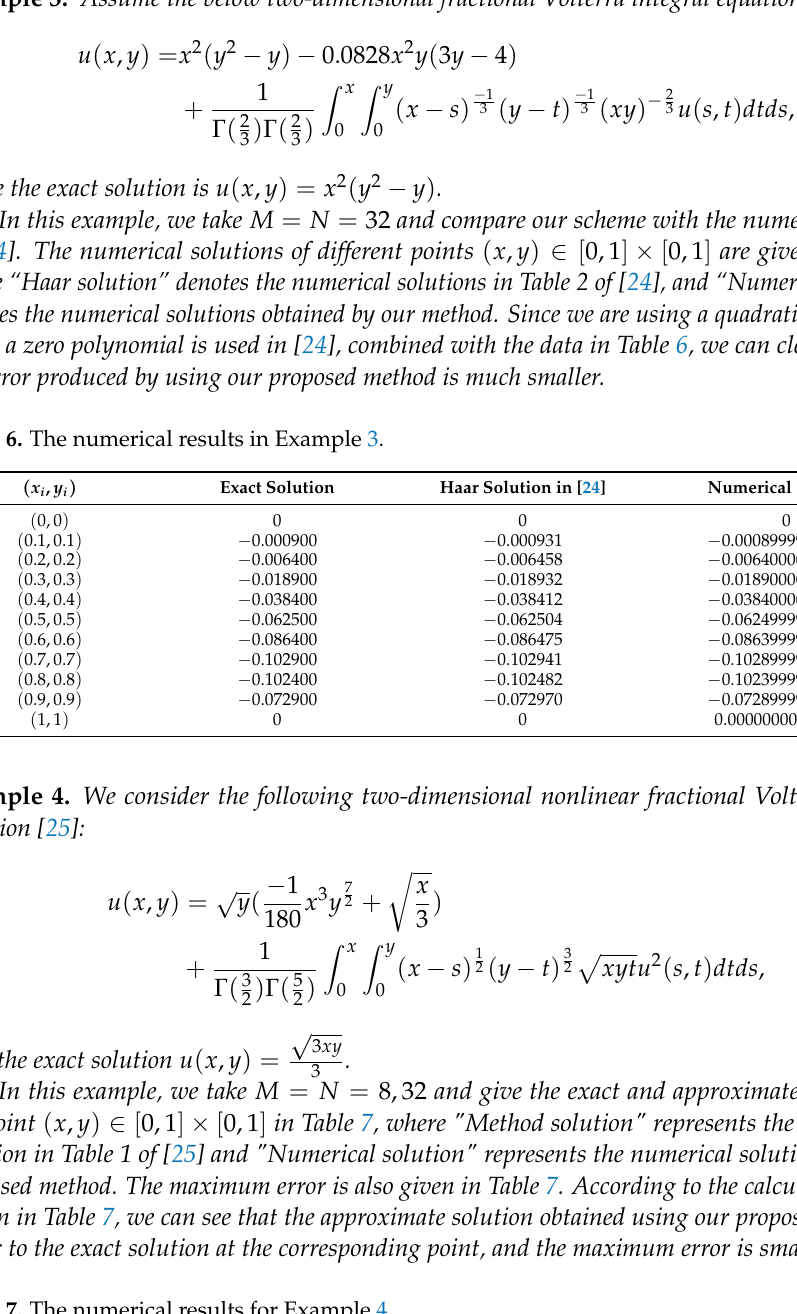
Table 7. The numerical results for Example